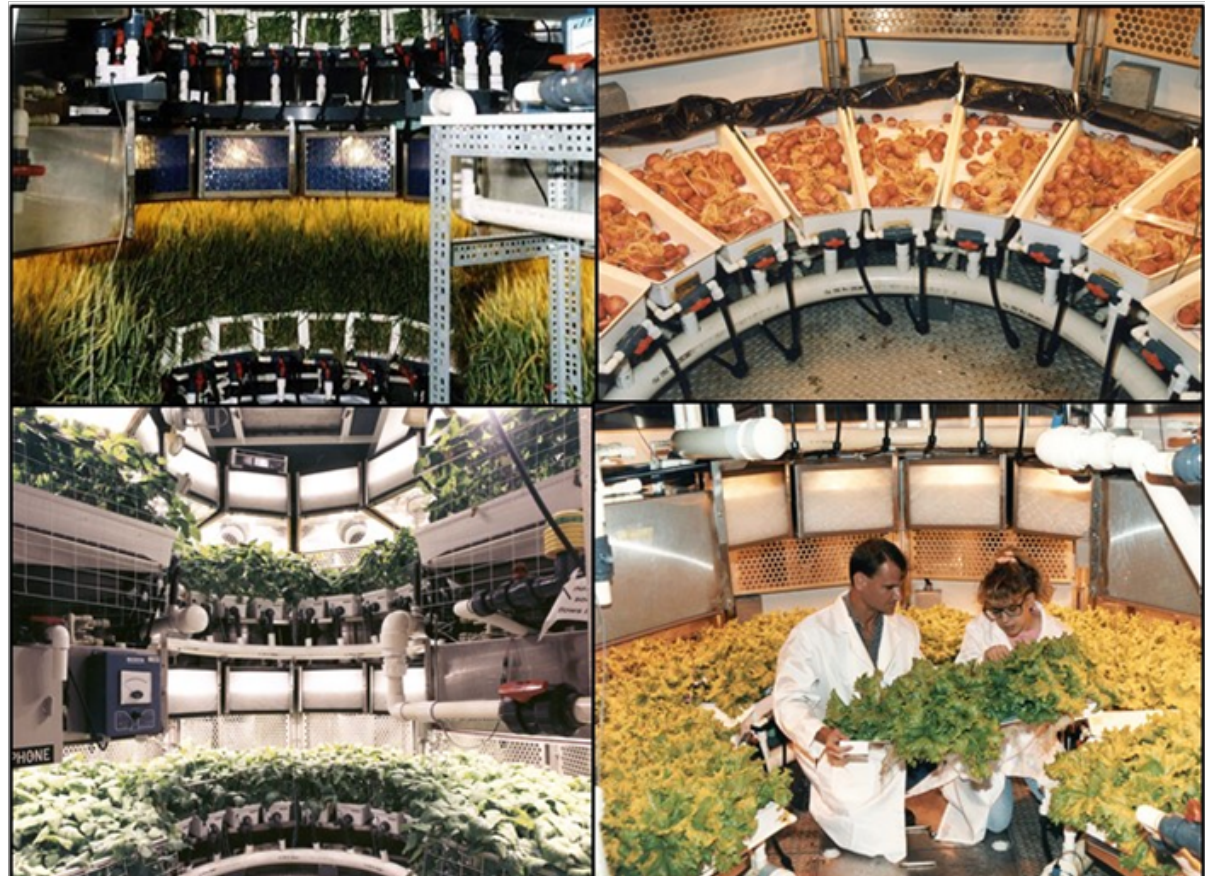
Figure 3. NASA’s Biomass Production Chamber (BPC), which operated from 1988 to 2000 at Kennedy Space Center, Florida. Crops tested included wheat (upper left), potato (upper right), lettuce (lower right), soybean (lower left), tomato, rice and radish (not shown). All crops were grown using hydroponics (nutrient film technique) with higher pressure sodium and or metal halide lamps. NASA’s BPC was one of the first working examples of a vertical agriculture system. KSC researchers Neil Yorio and Lisa Ruffe are shown in the lower right panel. Photos provided by